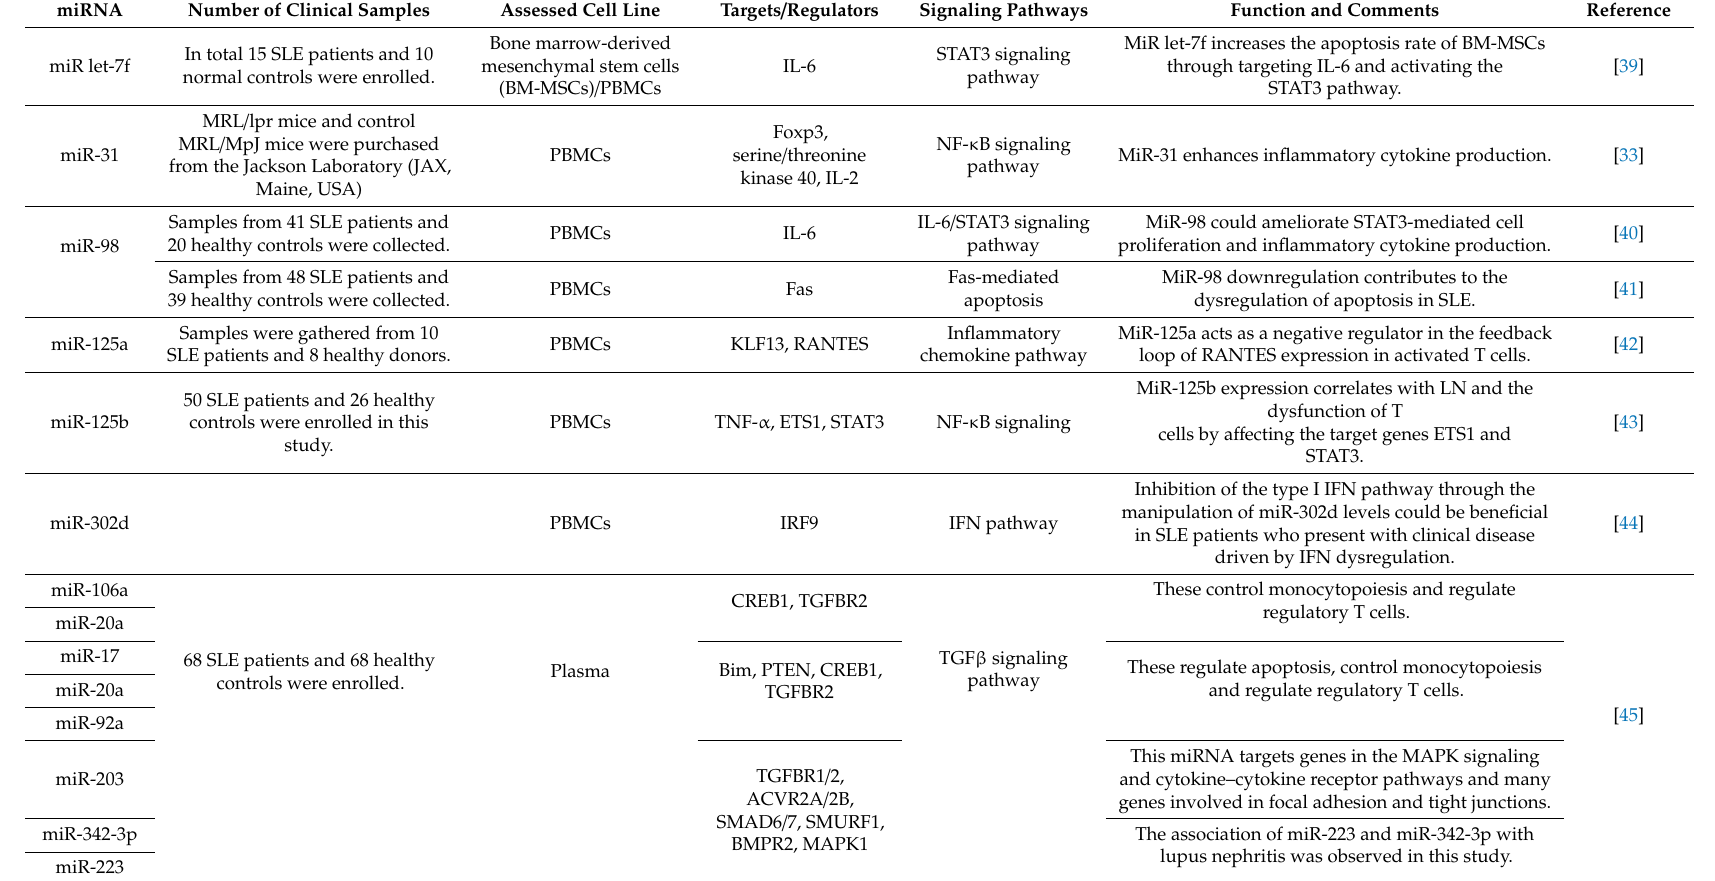
Table 4. List of miRNAs whose expression has been downregulated in SLE